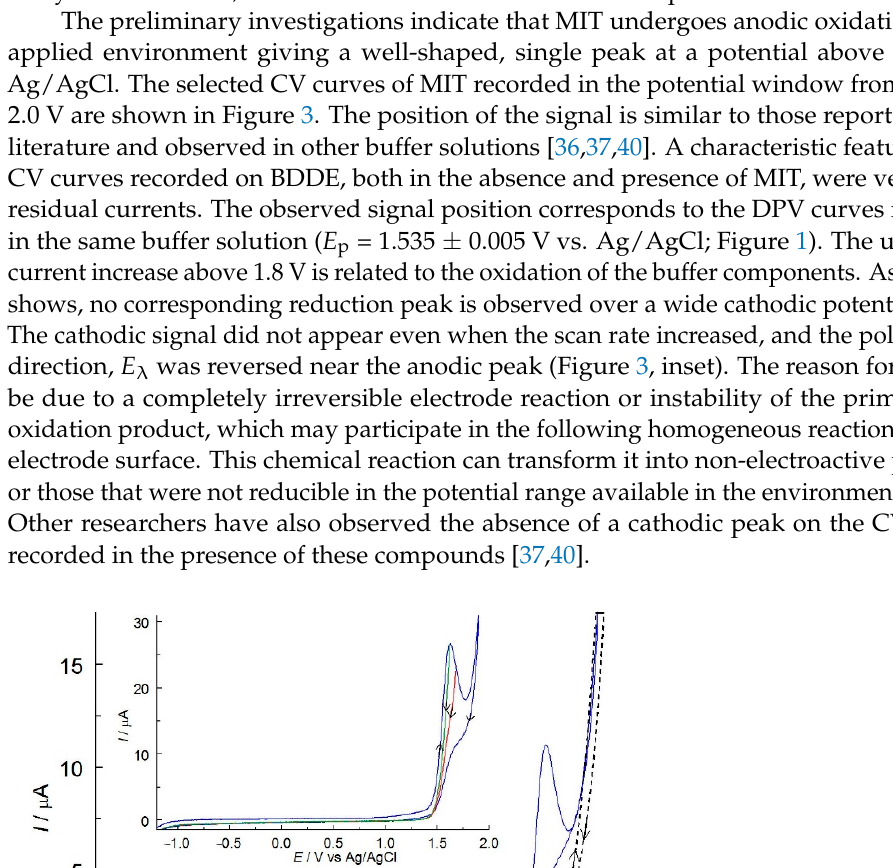
Table 1. Optimization of DPV parameters.